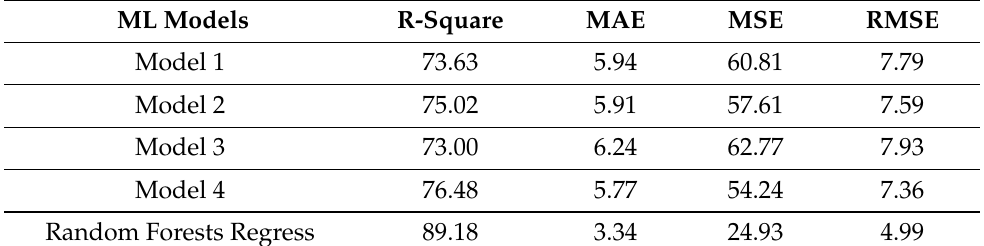
Table 4. Path loss evaluation metrics.